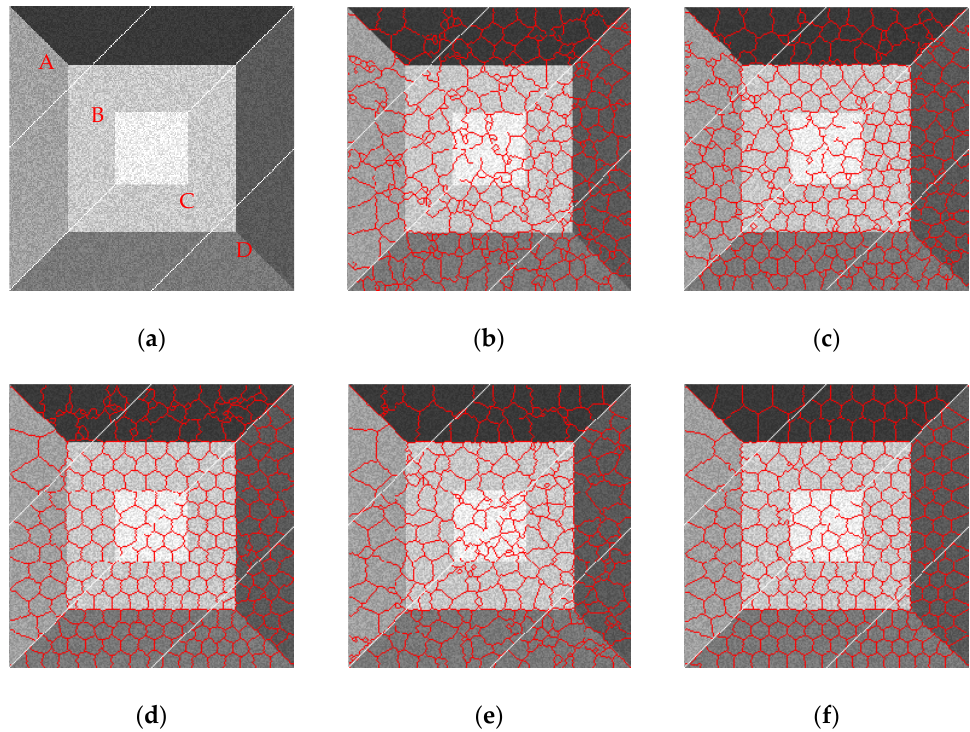
Figure 12. Resulting superpixels with m set to eight, v set to 0.075, and K set to 100, 200, 300, and 400 for regions A, B, C, and D, respectively. ( a ) Original; ( b ) SLIC; ( c ) PILS; ( d ) LBSLIC; ( e ) PBSLIC; ( f ) PSDSD.